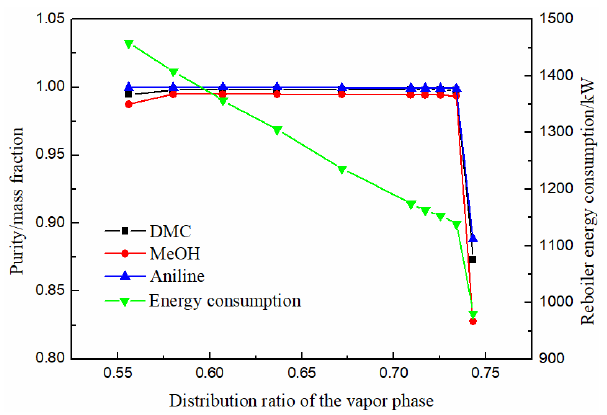
Figure 9. Effect of distribution ratio of the vapor phase on product purity and heat duty of reboiler.